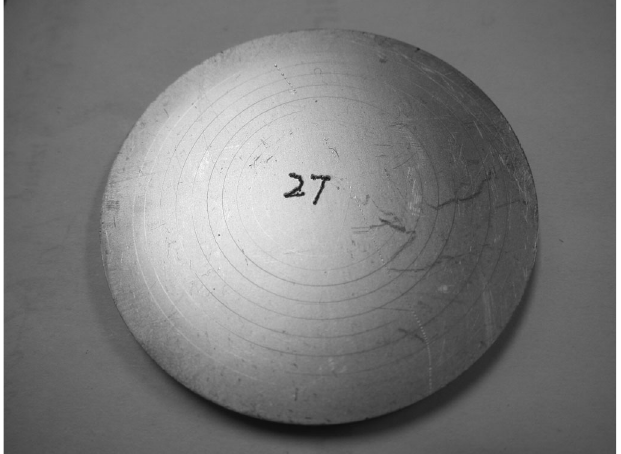
FIG. 3. A niobium sample disk with laser treated